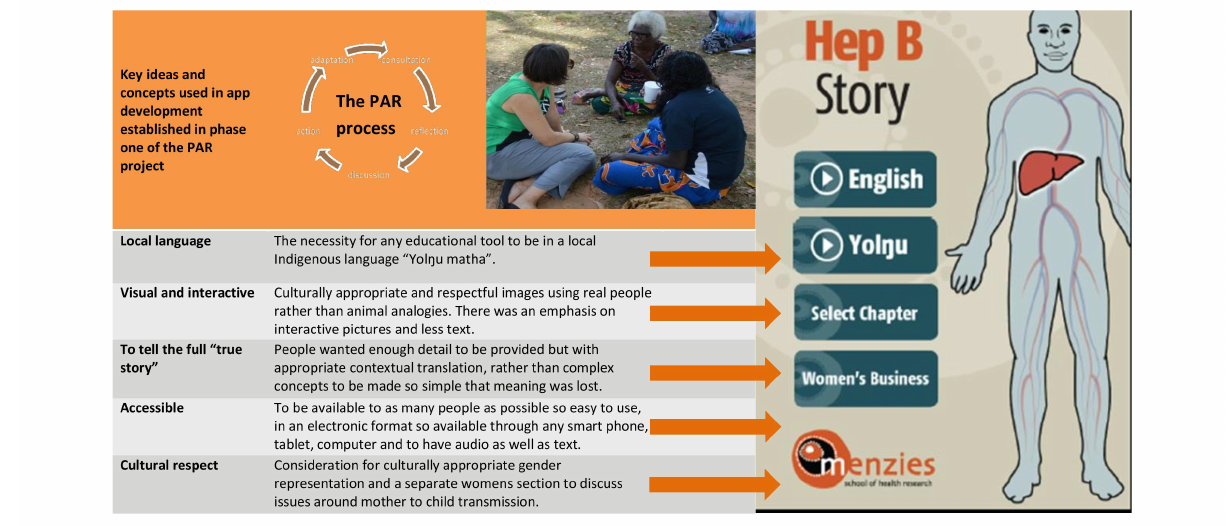
Figure 2. Main concepts and ideas taken from phase 1 [23] of the participatory action research (PAR) process to provide the initial evidence base for the culturally appropriate hepatitis B electronic app. The PAR cycle shows the principle stages involved in a PAR project.